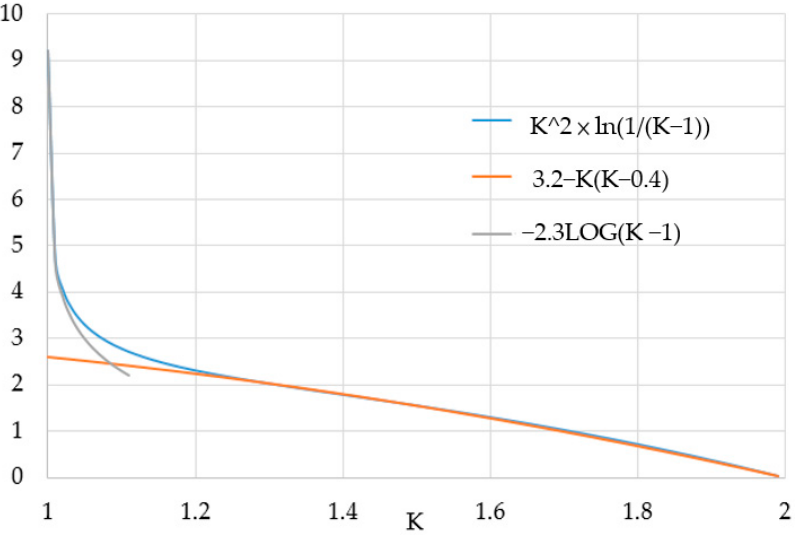
Figure 5. Linear interpolation of K .